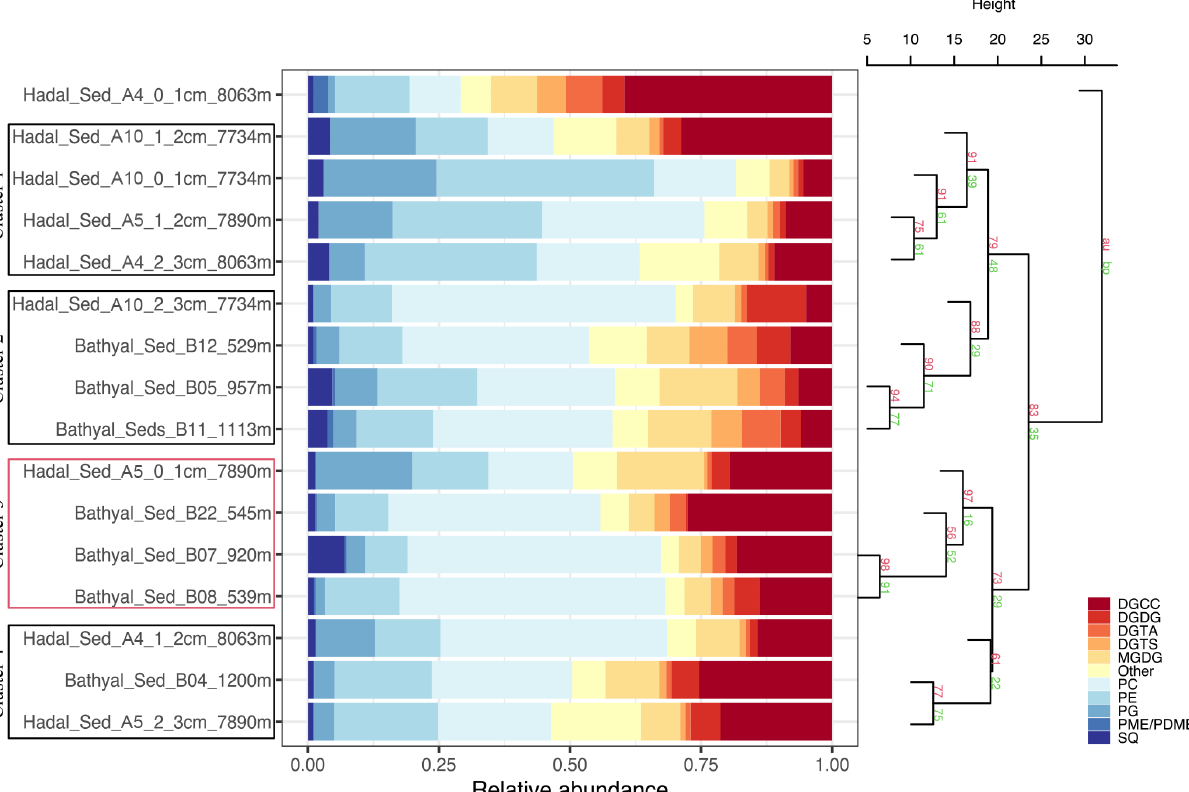
Figure 2. Cumulative bar charts of the fractional abundance of IPL classes in each surface sediment sample from the bathyal and hadal regions (left panel). Samples were grouped according to arithmetic mean (UPGMA) hierarchical clustering based on Euclidean distances. The p values are shown at branches, with AU in red and BP in green (right panel). Clusters 3 with an AU ≥ 95% confidence are indicated by the red rectangles (left) and are considered to be strongly supported by the